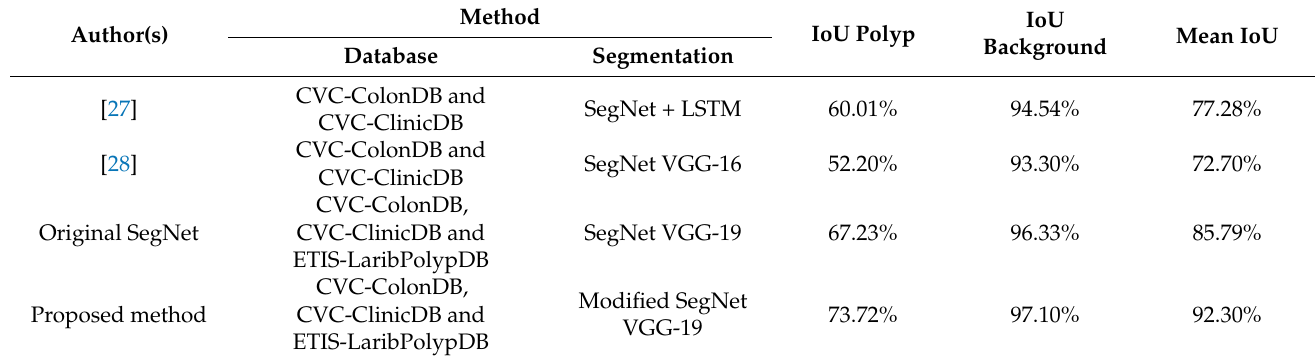
Table 5. Comparison of our modified SegNet model with the networks in [27,28] and the original SegNet